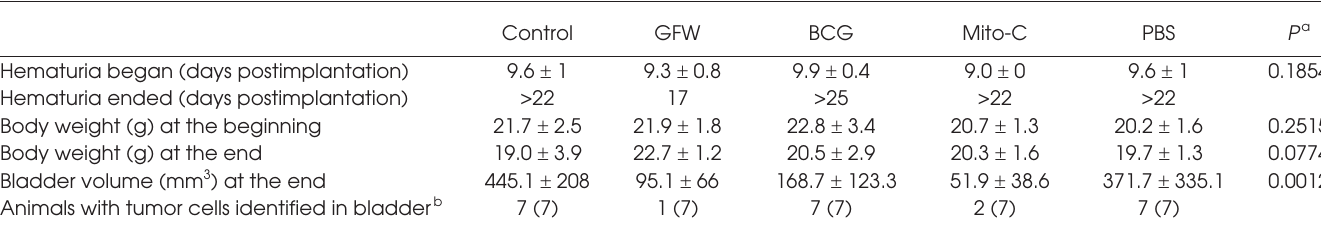
Table 1. Parameters in orthotopic bladder tumor model with and without intravesical